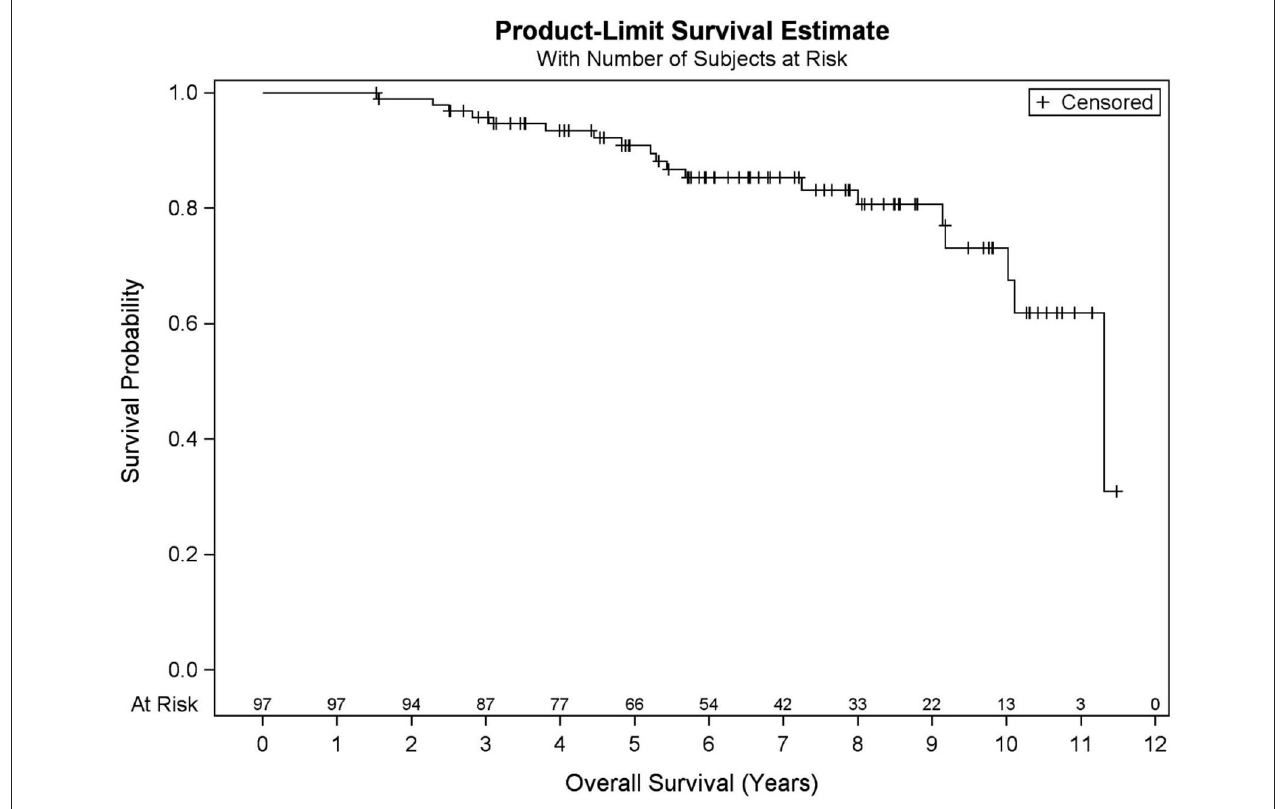
FIGURE 1 | Kaplan–Meier curve for overall survival in all patients ( N =